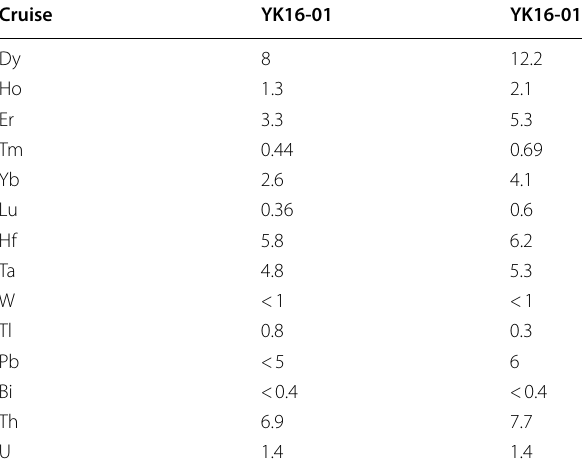
Table 1 Major and trace element composition of